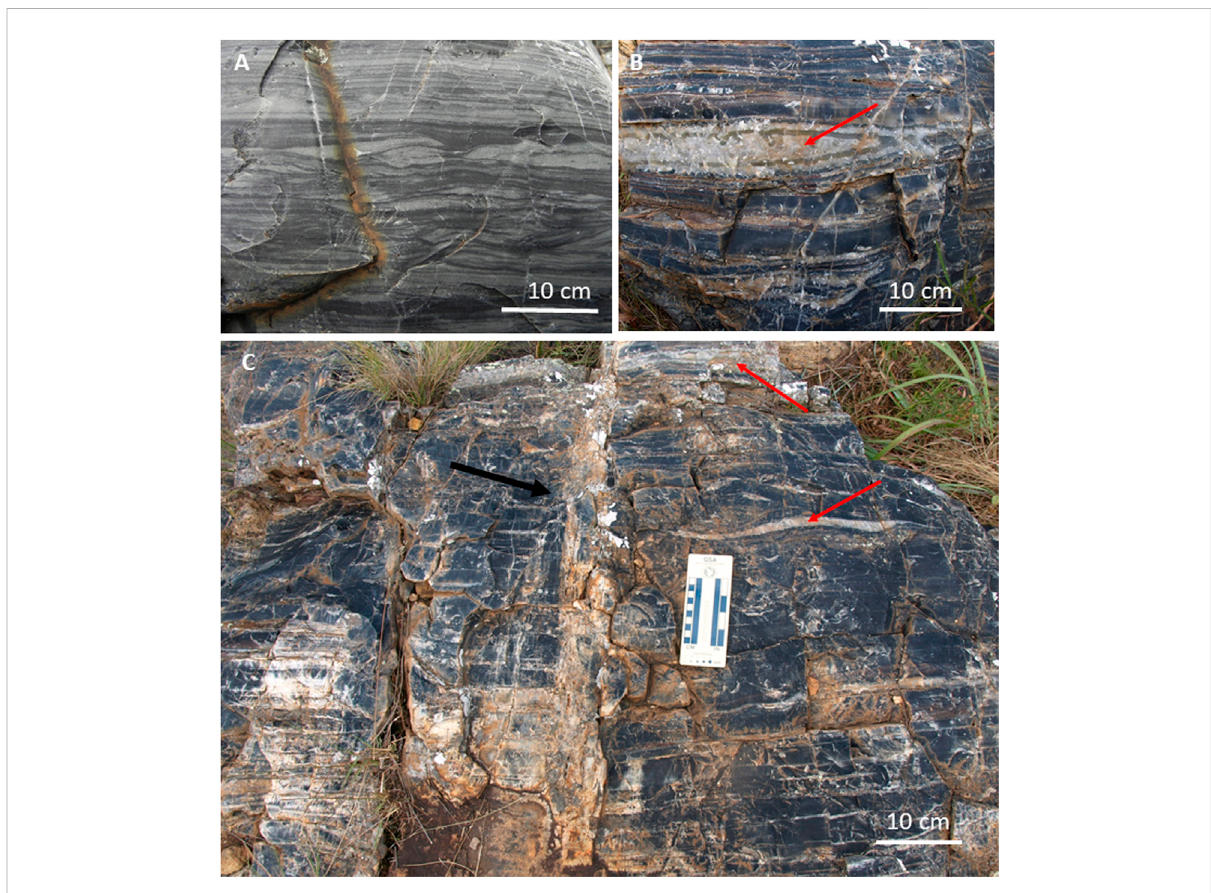
FIGURE 5 The effects of silici fi cation on volcanic sediments, examples from the 3.33 Ga Josefsdal Chert, Barberton Greenstone Belt, South Africa. (A) Layers of volcanic ashfall deposited in a littoral setting and away from direct hydrothermal in fl uence with a total silica concentration about 96% (@J.Bréhéret). (B) Similar sediments deposited close to hydrothermal activity with a total silica concentration > 99.9%. Note the bedding parallel hydrothermal in fi ltration and possible vadose crack indicating subaerial exposure (red arrow). (C) Hydrothermal vein traversing the horizontally laminated shallow water sediments (black arrow) and lateral in fi ltrations of hydrothermal fl uids into already slightly consolidated sedimentary layers (red